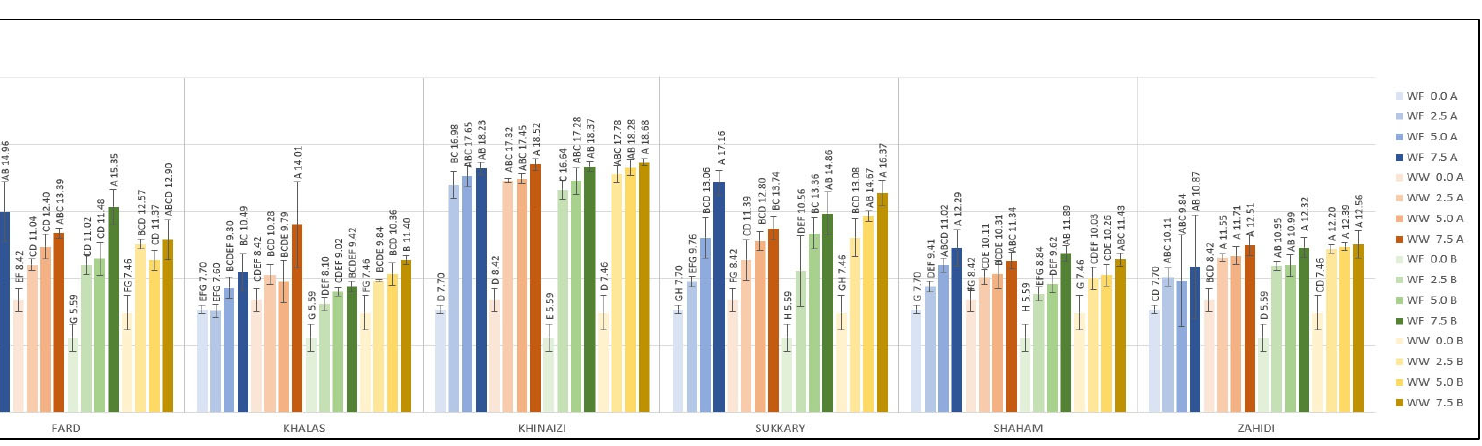
Figure 5. DPPH radical scavenging activity ( μ g Trolox equivalent / g) of composite cookies formulated with 2.5%, 5%, and 7.5 % substitution of flour by date seed powder Different uppercase superscript letters in a variety denote significant differences, p < 0.05. (A—180 °C, B—200 °C).